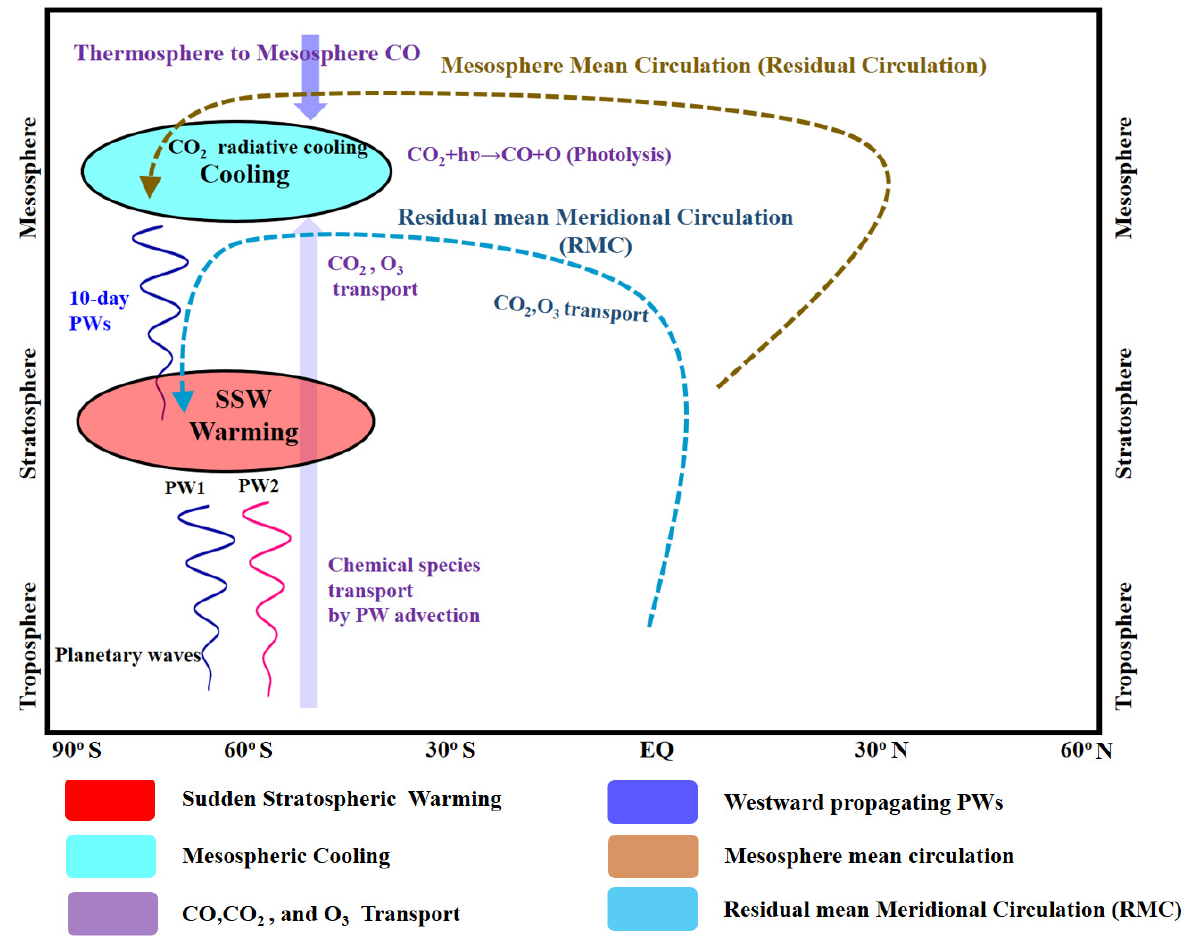
Figure 7. Schematic illustration (not to scale) of SSW effects on the polar mesospheric cooling by planetary wave propagation and chemical species during the 2019 SH minor SSW. (PW = planetary waves, SSW = stratospheric sudden warming).